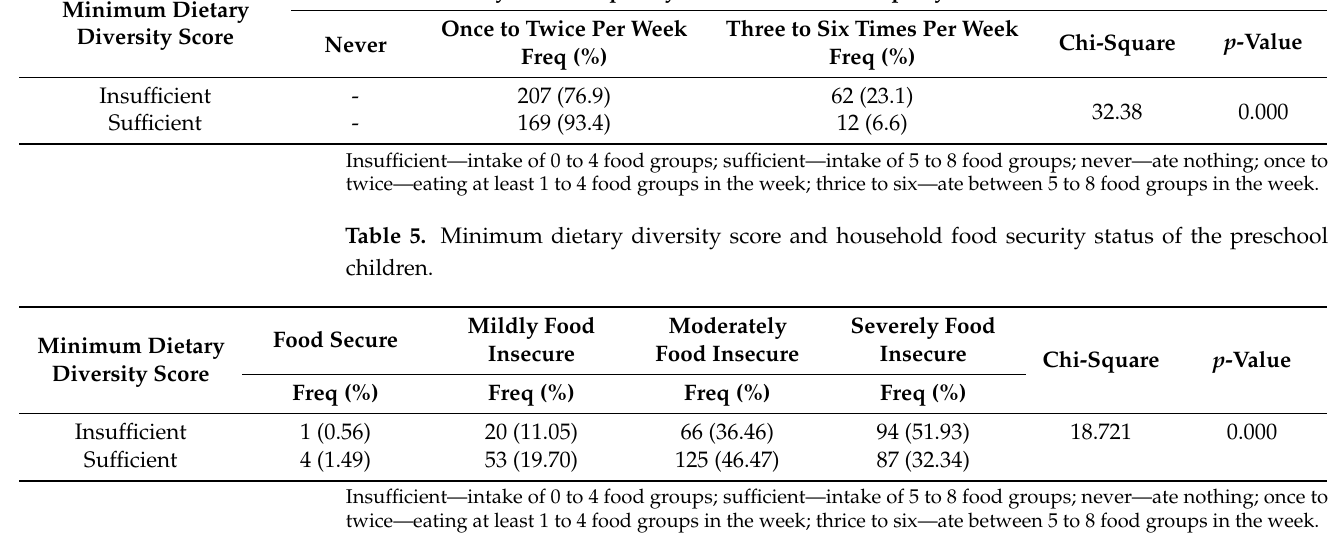
Table 6. Weekly food frequency consumption patterns of the preschoolers and their food security